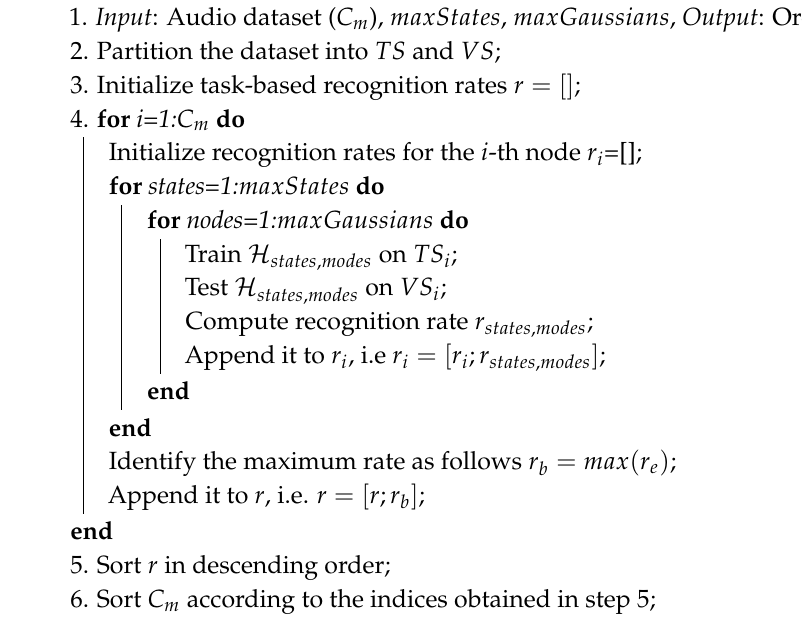
Algorithm 1: The algorithm for determining the topological ordering of G .